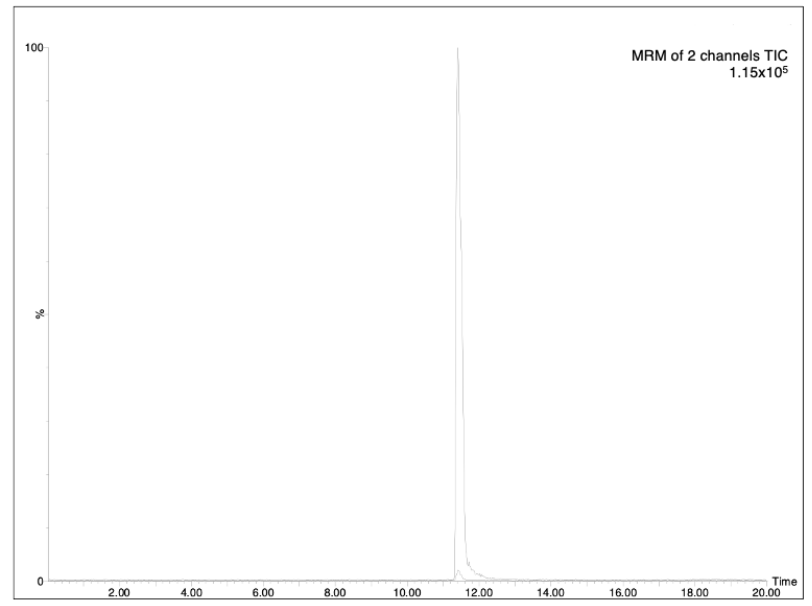
Figure 2. Specificity of the selected method, MRM of standard solution of AzA (500 ng/mL) against